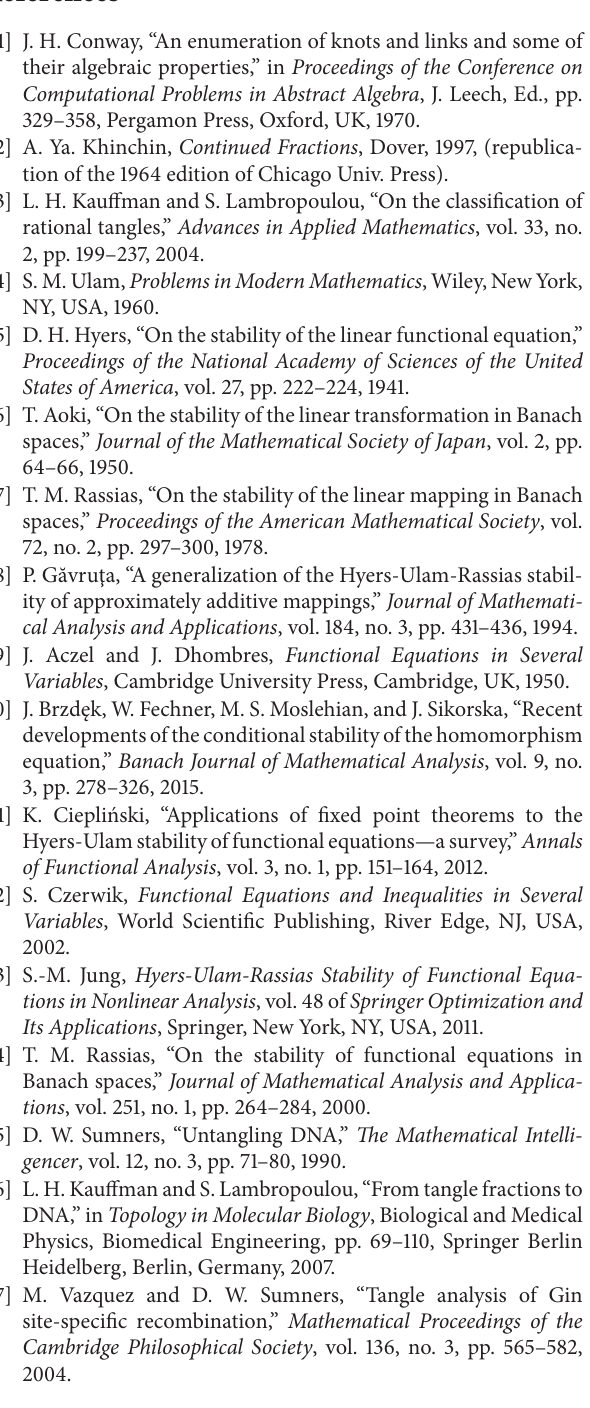
Figure 9: Example of a site-specific recombination.